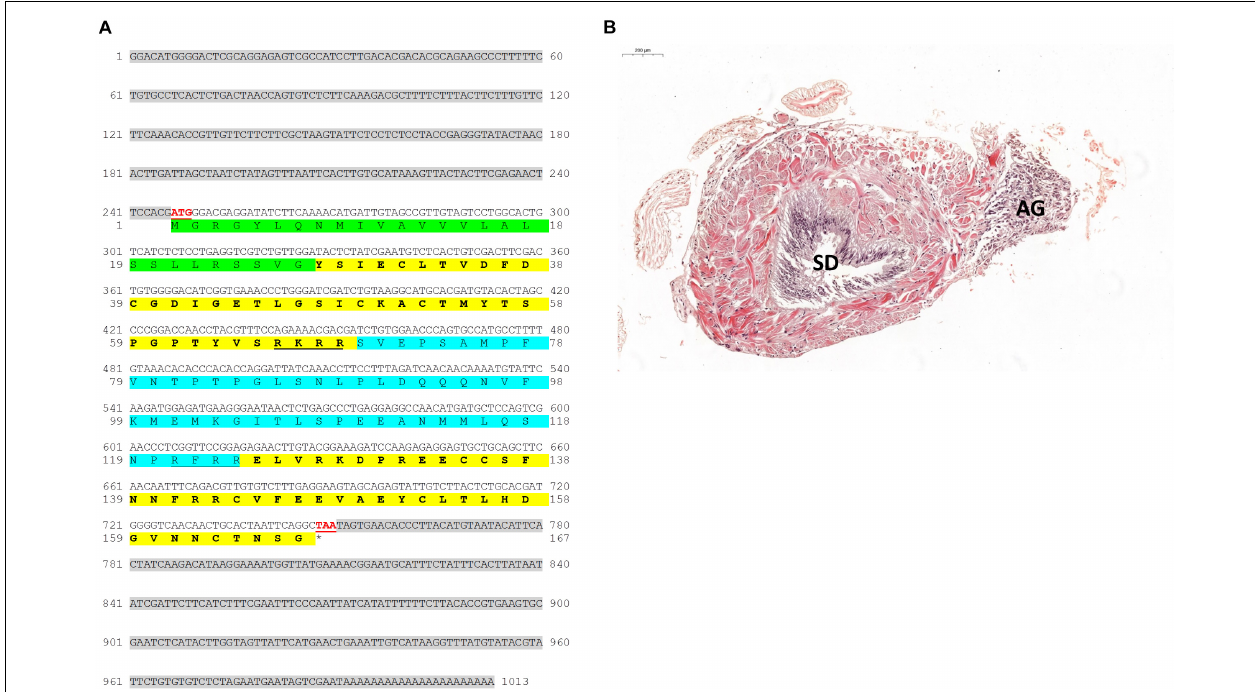
FIGURE 1 | IAG and AG in P. platyceros . (A) Predicted structure of Pnp-IAG. The full sequence of Pnp-IAG mRNA and its open reading frame (ORF)-deduced amino acids. 5 (cid:48) (first) and 3 (cid:48) (second) UTR’s are highlighted with gray background. The signal peptide is highlighted with green background. B (first) and A (second) chains are highlighted with yellow background, with C peptide (blue background), including its cleavage sites (underlined), flanked between them. The start (ATG) and stop (TAA) codons are shown in red and underlined. The stop codon is also indicated with an asterisk. (B) The androgenic gland in P. platyceros (magnified × 6.1). Histological section of the fifth pereiopod base in a P. platyceros male stained with hematoxylin and eosin (H&E). The sperm duct (SD) and androgenic gland (AG) are indicated. Bar scale (200 µ m) is given.